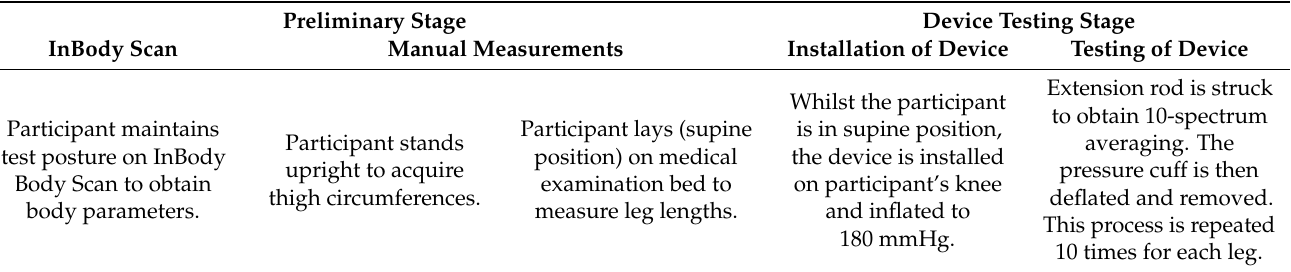
Table 2. Description of clinical trial procedure in each